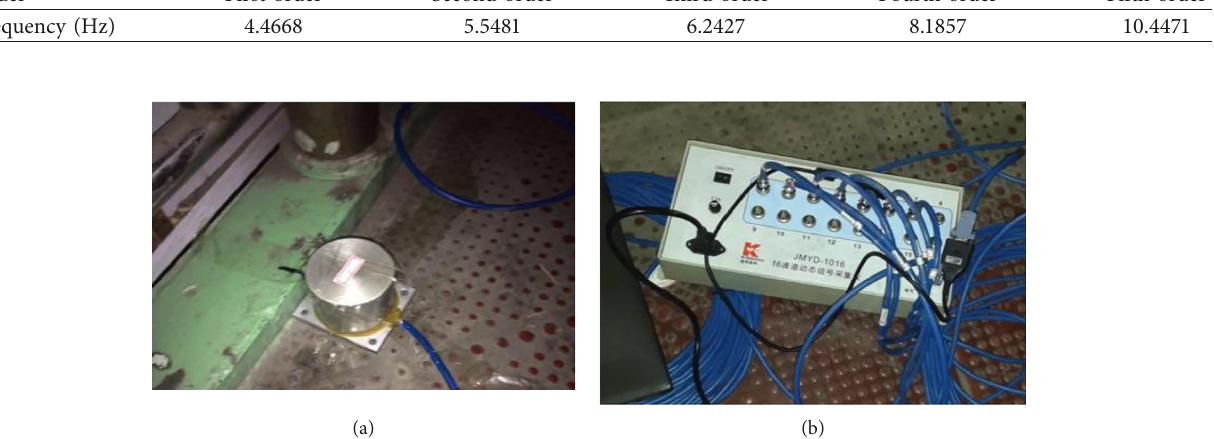
Table 1: Calculation table of the first five natural vibration frequencies of the pedestrian bridge. Order First